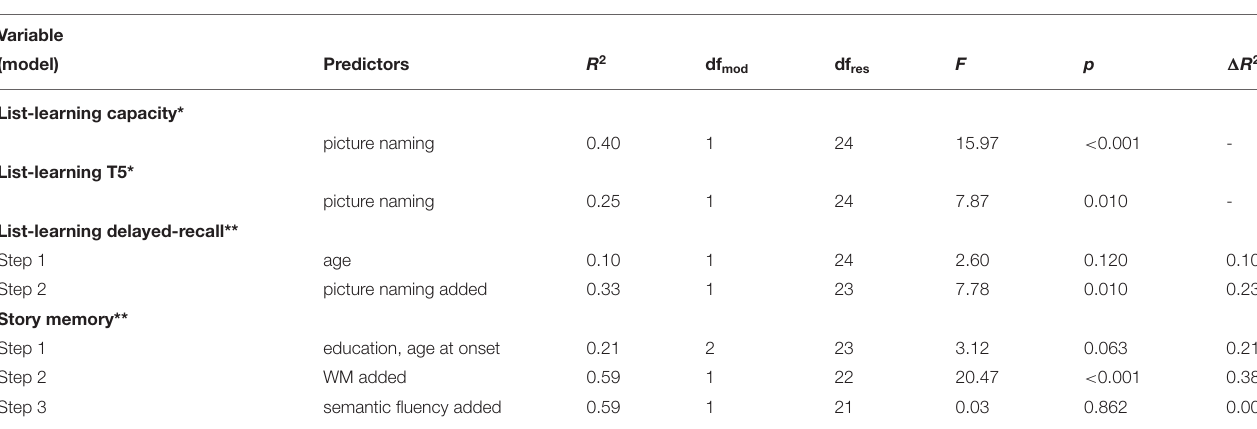
TABLE 3 | Model comparisons for variables predicting verbal learning and memory in RTLE. Variable